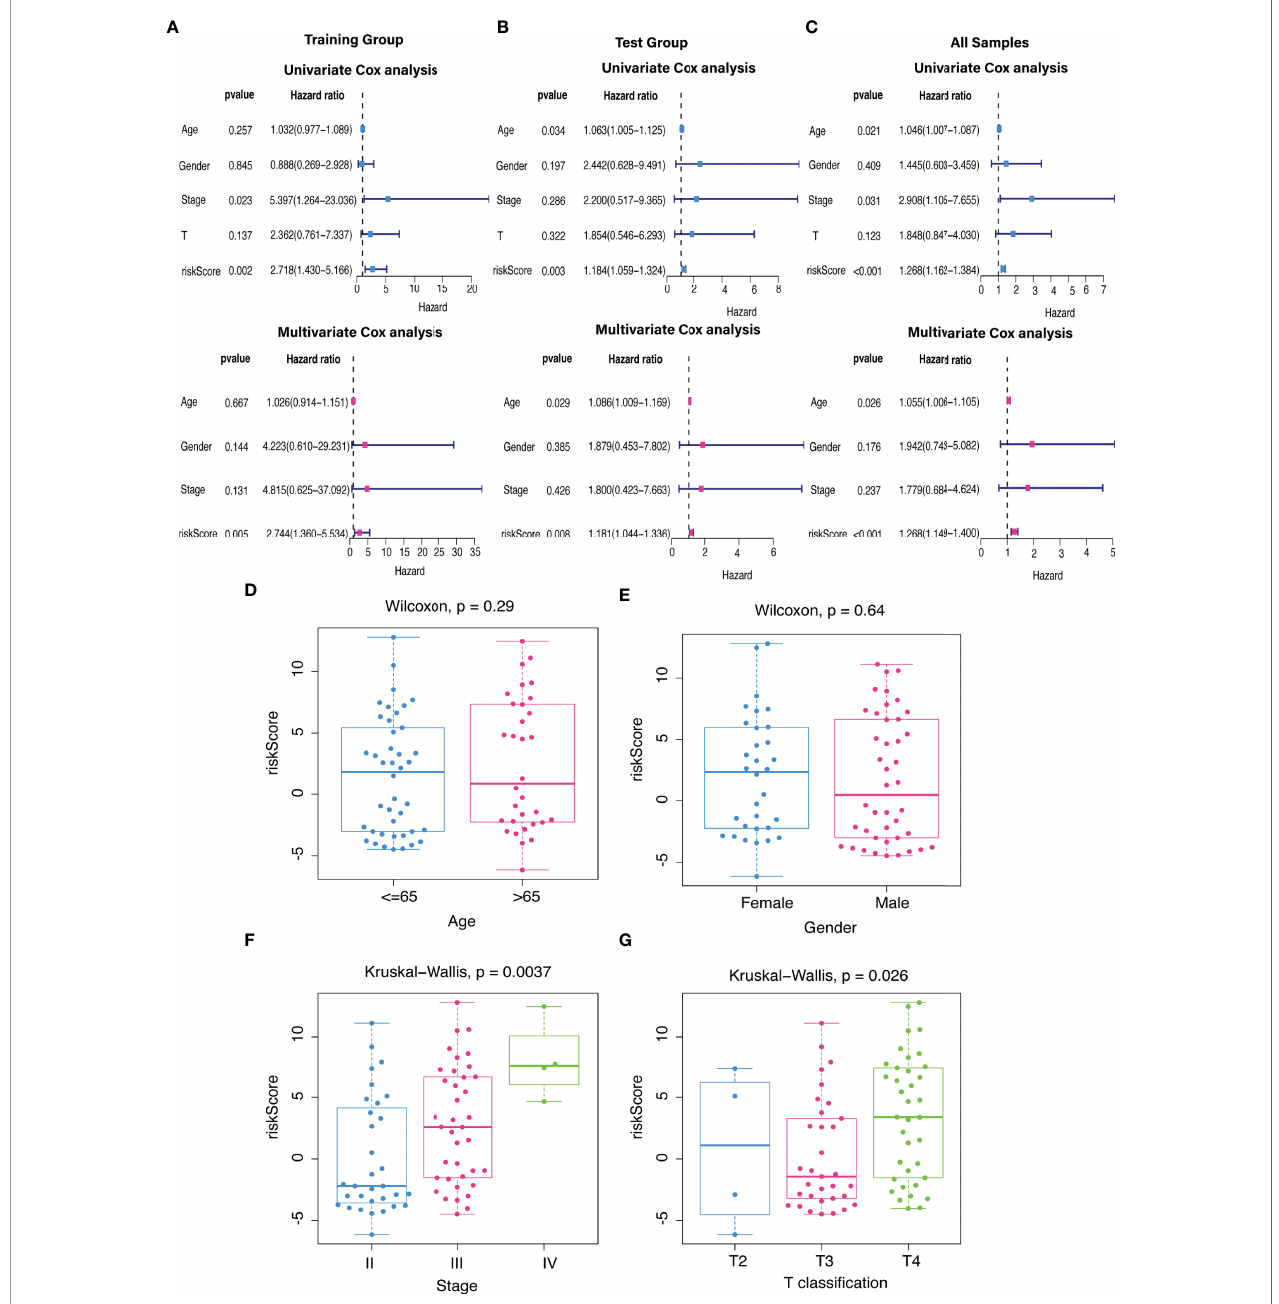
FIGURE 7 | The independent prognostic value. (A – C) The forest plots for univariate and multivariate Cox regression analysis in (A) training, (B) validation, and (C) total groups. (D – G) Different levels of risk scores in UM patients strati fi ed by (D) age, (E) gender, (F) stage, and (G) T classi fi